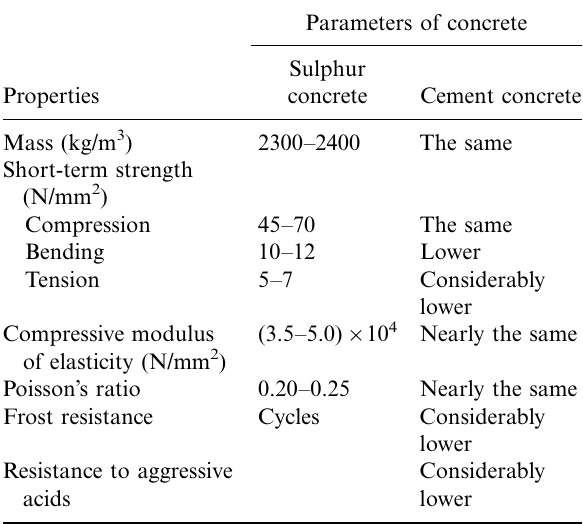
Table 1. Comparison of the properties of sulfur concrete and cement concrete Parameters of